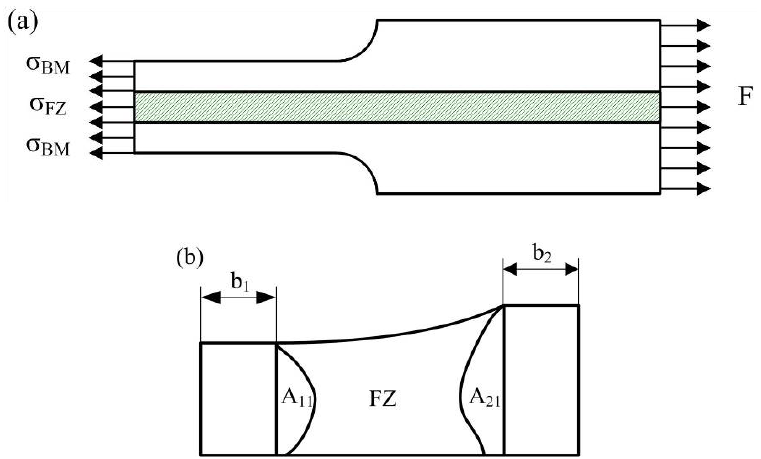
Figure 14. Schematic diagram of ( a ) the uniaxial tensile mechanical model of TWB sample and ( b ) the cross-section of tensile sample.